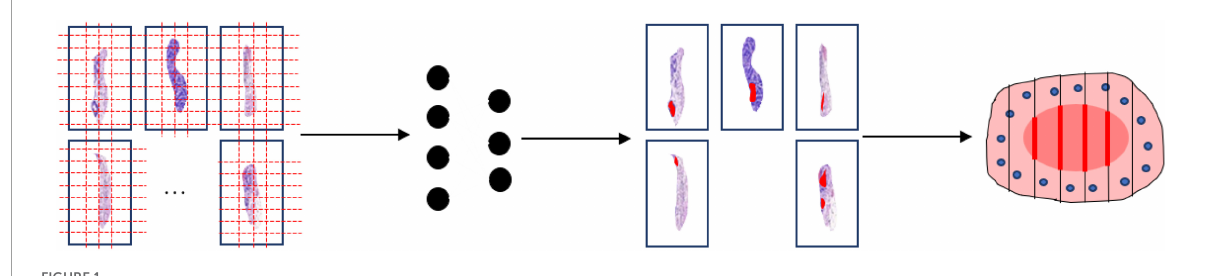
FIGURE1 Work flow of the segmentation model. The whole slide images are split into patches (far left) . Then the patch-level annotation is obtained with the trained segmentation model (near left) . The patch-level annotation is mapped back to the WSI-level annotation based on their original location (near right) . Finally, these WSI-level annotations are shown on an image of the entire specimen.